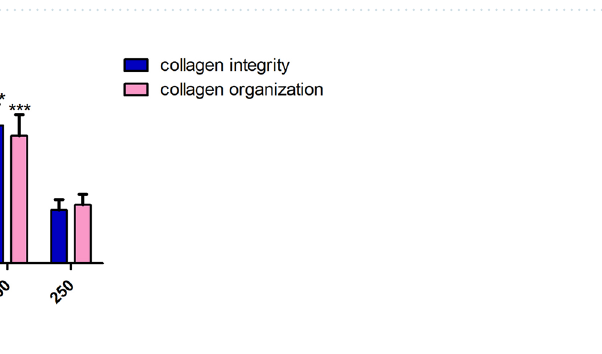
Figure 2. Histological analysis of Ag NPs treated Tilapia skin at concentrations of 25, 50, 100, 250 µg/mL. ( A ) Compactly arranged collagen fibers in control group. ( B ) Collagen fibers were loose showed wavey pattern at 25 µg/mL. ( C ) Collagen fibers were wavey and slightly disorganized at 50 µg/mL. ( D ) Highly disorganized collagen fibers were observed at 100 µg/mL. ( E ) Collagen fibers were compactly arranged and slightly loose at 250 µg/mL. ( F , K ) Normal structure of the skin components. ( G , L ) Moderate change in collagen intensity and organization at 25 µg/mL. ( H , M ) Mild change in the disposition pattern of collagen fibers and the collagen intensity at 50 µg/mL. ( I , N ) Marked reduction in intensity of the collagen fibers at 100 µg/mL. ( J , O ) Fish skin showed well-organized collagen fibers and high percentage of collagen intensity at 250 µg/mL. ( A – E stained with HE, F – J stained with Crossmon’s trichrome, K–O are negative image).